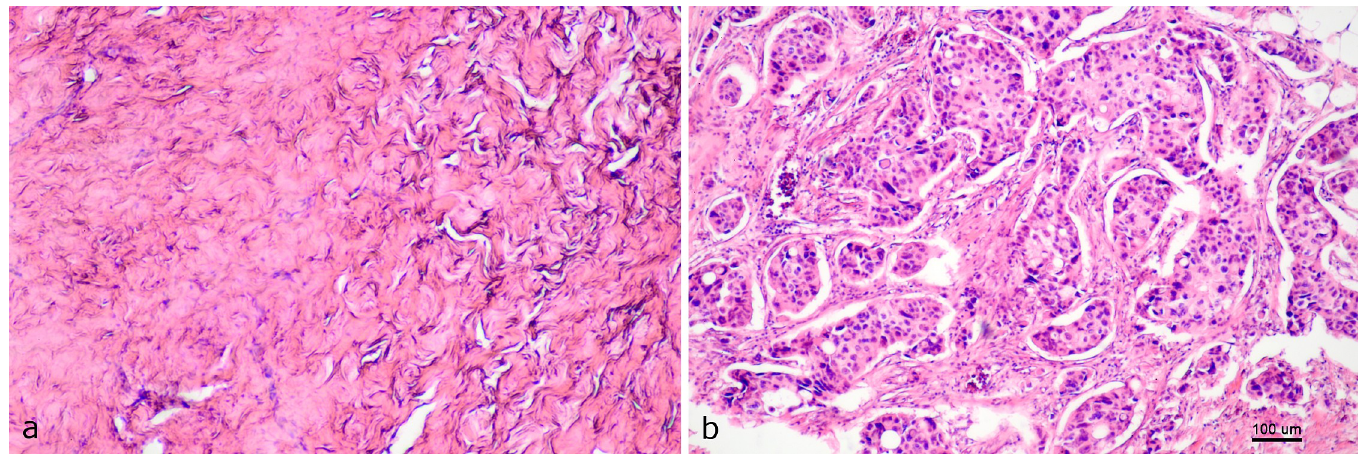
Fig 1. Histopathological images of the responding (PR) and non-responding (N-PR) breast tumors. In a PR tumor, there was a lack of tumor cells (a), in the N-PR tumors, malignant cells persisted (b).